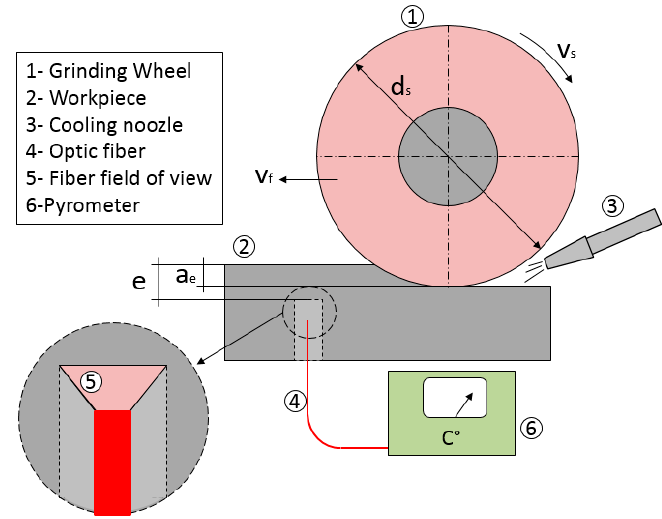
Figure 3. Experimental setup scheme.